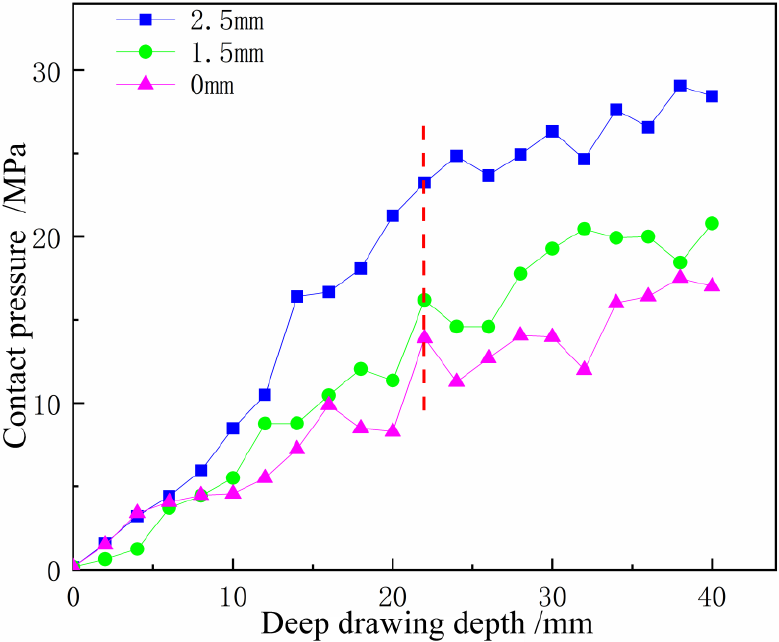
Figure 19. Draw depth – contact pressure curves at different drawbead height.